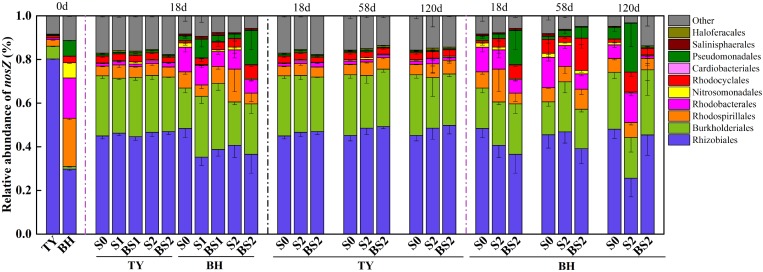
Taxonomic distribution of nosZ I gene derived OTUs at the order level in paddy soils over time. Other includes the sequences with a relative abundance less than 0.8% and the unclassified sequences. Mean ± SD, n = 3. 0d represents the original soil used in this experiment.